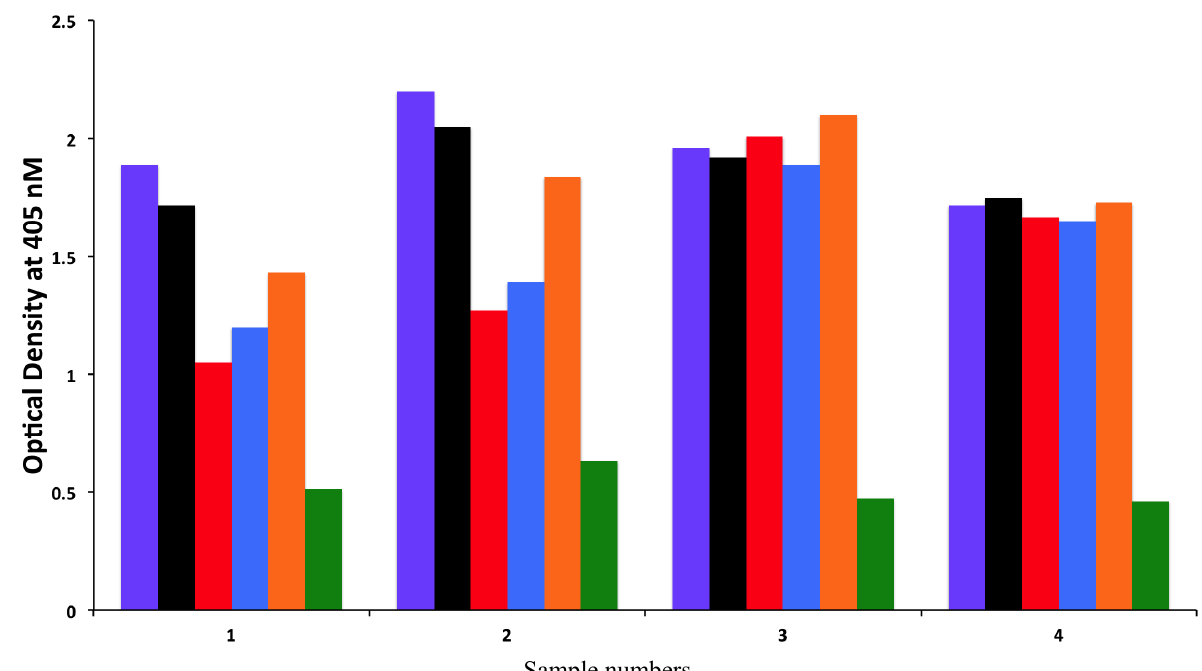
Figure 6. Inhibition of immune reaction of sera containing high levels of IgG, IgM and IgA antibody against cerebellar before  and after absorption with HSA  , wheat  , gliadin peptide  , GAD-65  and cerebellar peptide  .